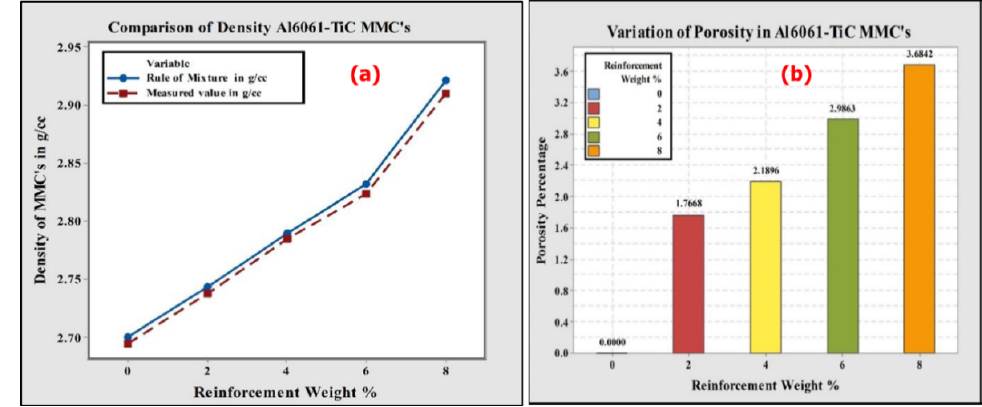
Figure 2. ( a ) Weight-to-volume ratios and thermotical densities; and ( b ) porosity of Al6061-MMCs samples.